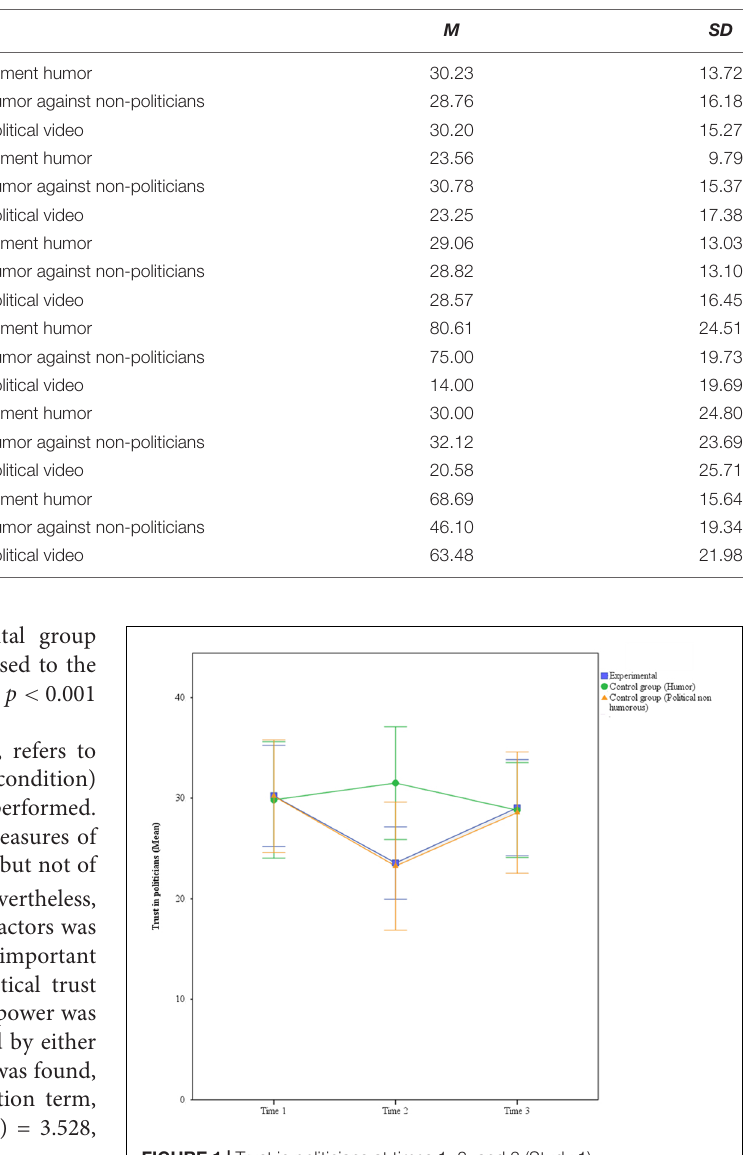
FIGURE 1 | Trust in politicians at times 1, 2, and 3 (Study